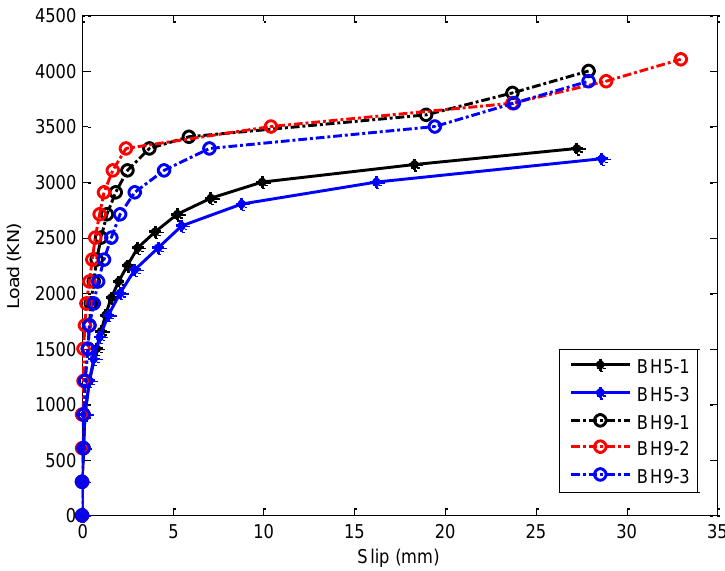
Figure 21. Load – slip relationship. Figure 21. Load–slip